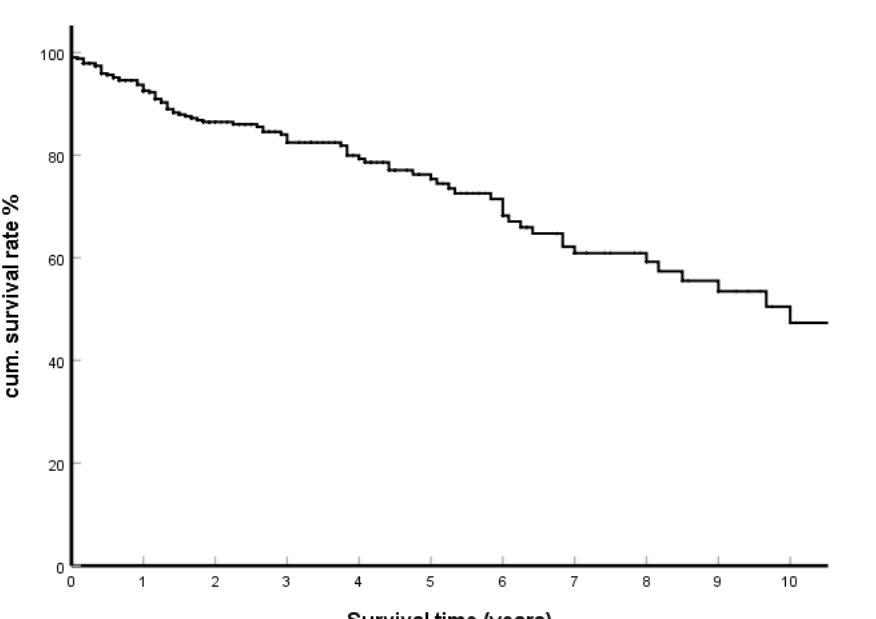
Figure 2. Kaplan–Meier survival curves; surgical treatment group (N = 415). These values are